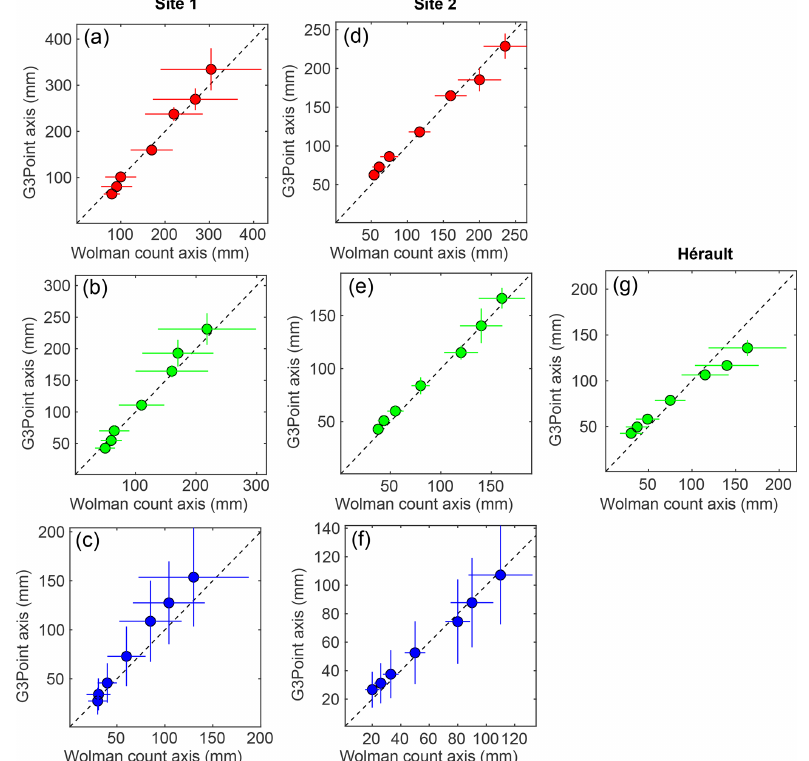
Figure 7. Comparison of the key percentiles (10th, 16th, 25th, 50th, 75th, 84th, 90th) obtained by manual counts and by G3Point at the three study sites and for the three diameters. Distributions from G3Point are derived from the virtual Wolman sampling and uncertainties correspond to the envelopes defined by the DLSF and IE models. For manual counts, uncertainties are derived from a bootstrap approach with replacements. The dash lines indicate a 1 : 1 ratio (points under/above the line indicate that G3point under/overestimates the percentile with respect to field